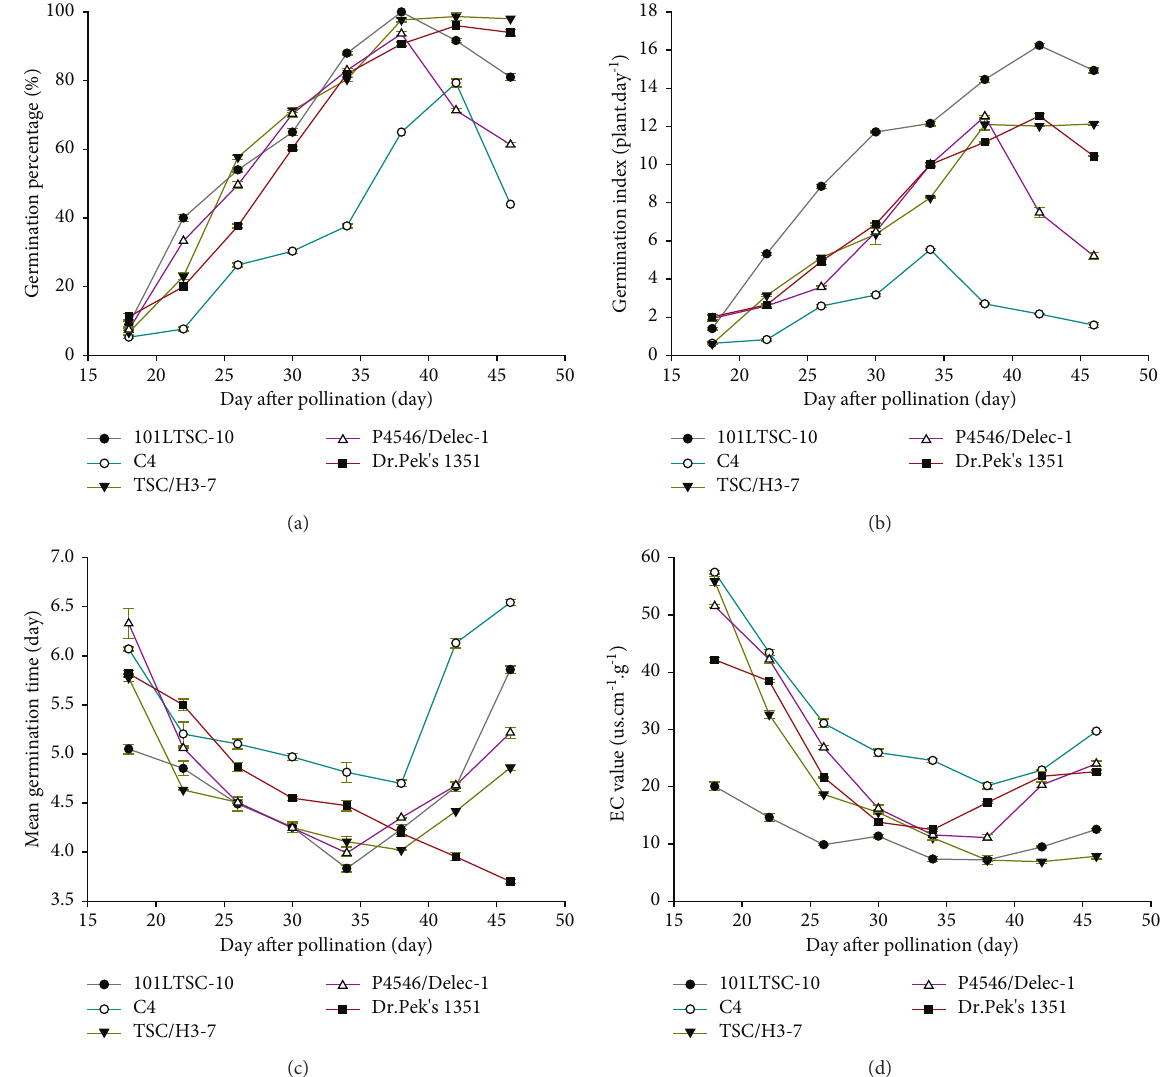
Figure 2: The changes of seed vigor parameters during seed developments of sweet corn: (a) seed germination percentage, (b) germination index, (c) mean germination time, and (d) EC value. The data are means of four replicate samples and error bar ± SD ( n �